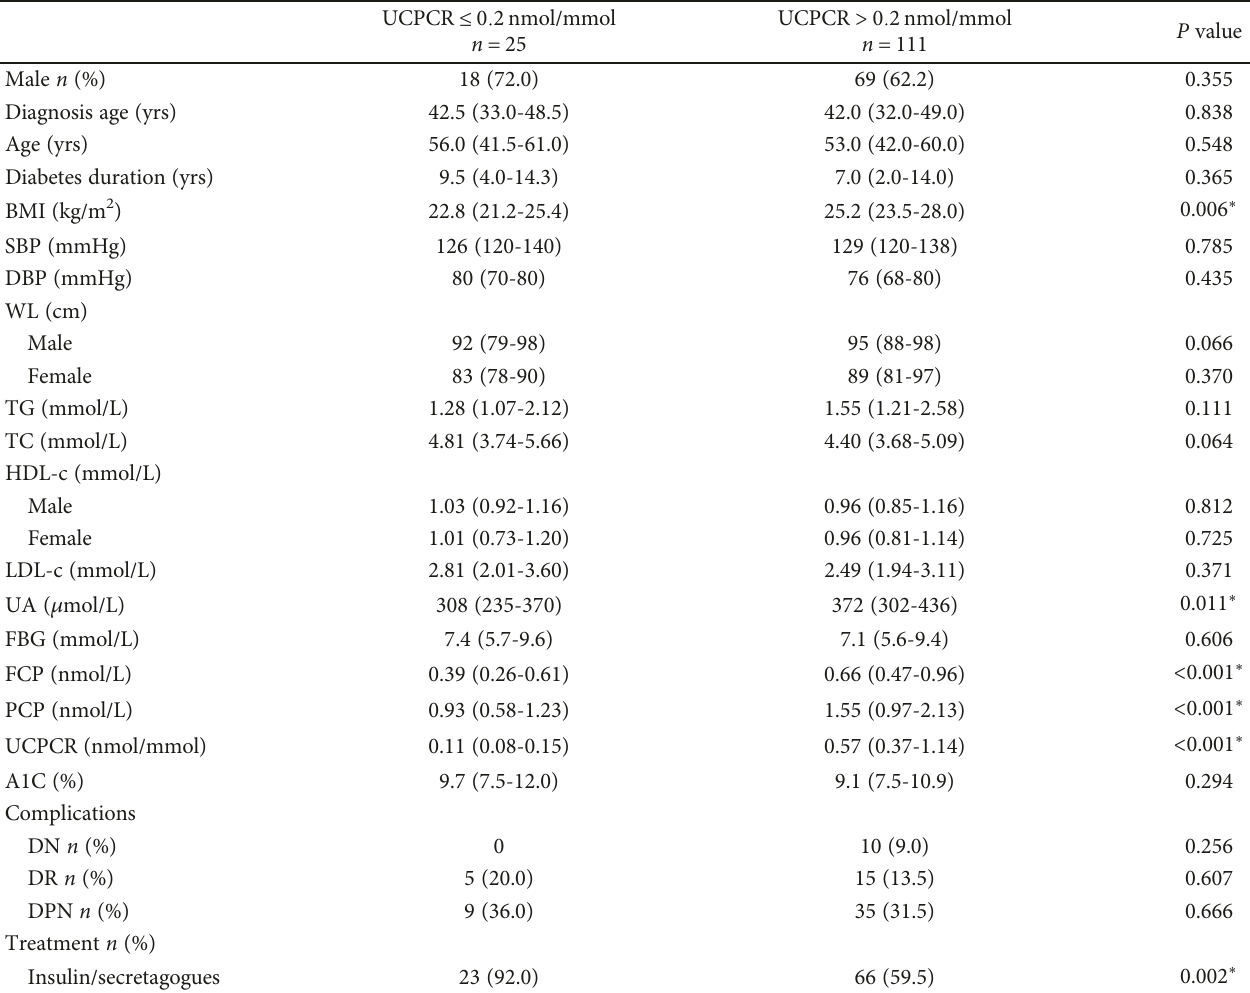
Table 2: Clinical characteristics of T2DM patients with UCPCR ≤ 0 2nmol/mmol vs. T2DM patients with UCPCR > 0 2 nmol/mmol